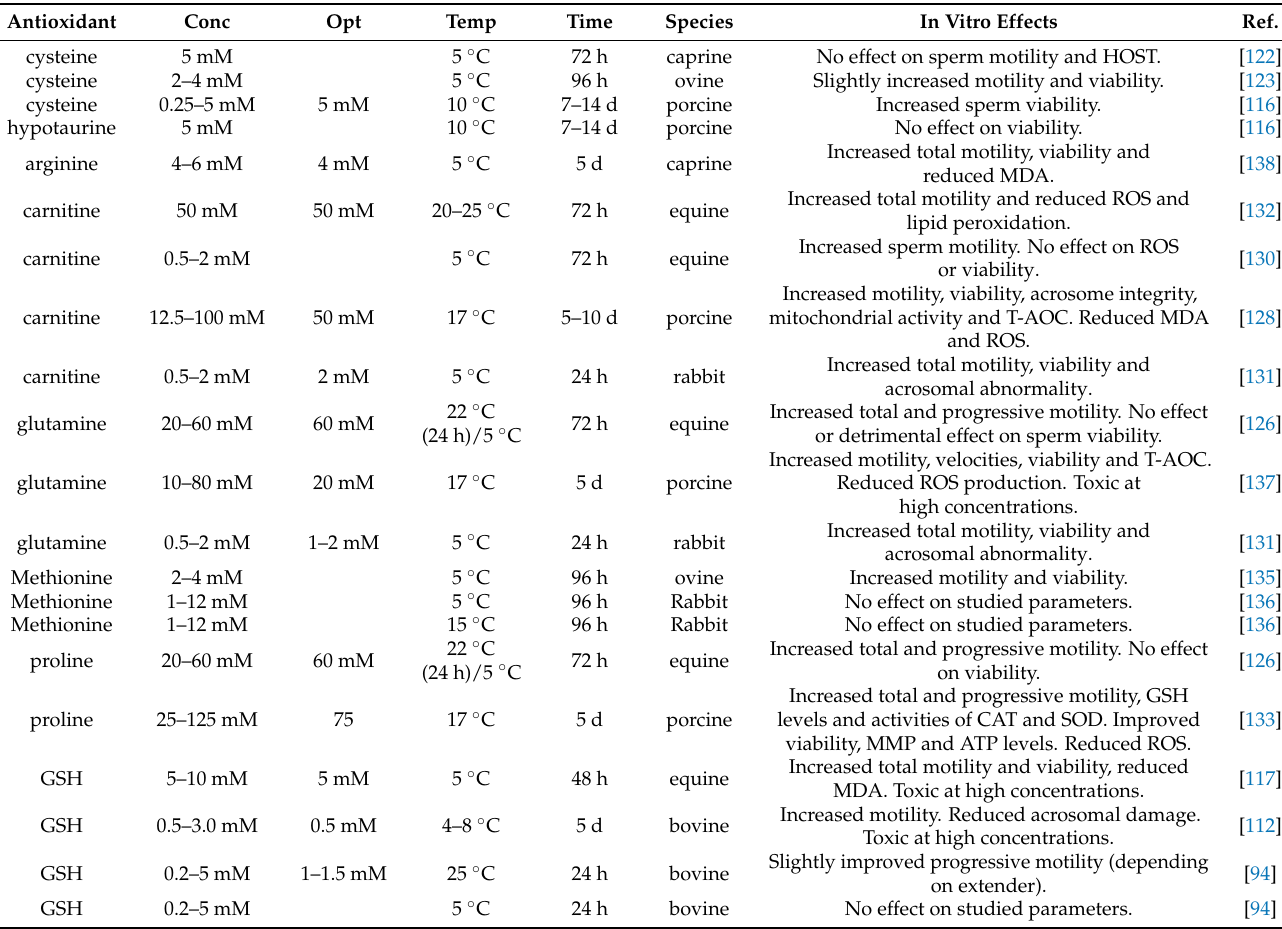
Table 2. Effects of non-enzymatic antioxidants (amino acids and small peptides) supplementation in liquid cooled storage on sperm quality